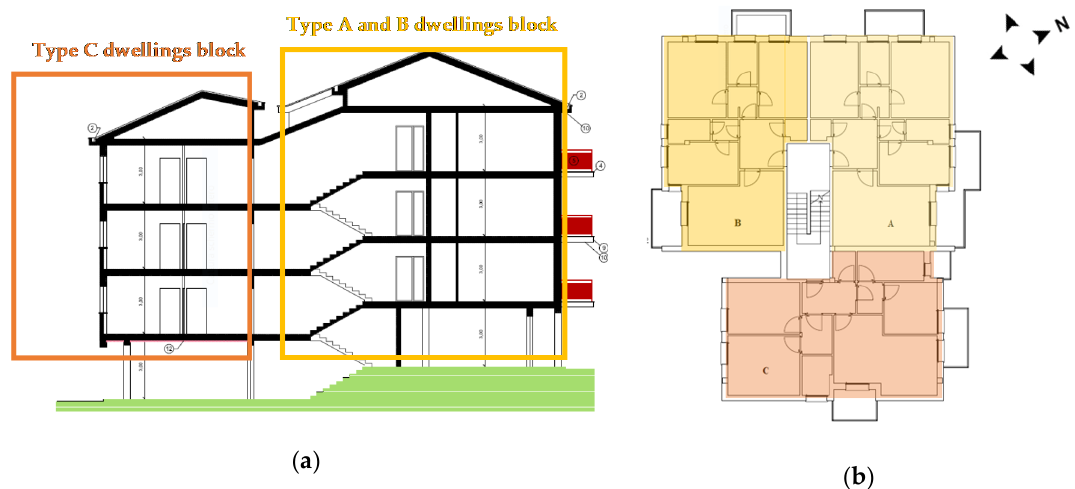
Figure 1. ( a ) Cross-section of the building case-study; ( b ) plant scheme of a representative